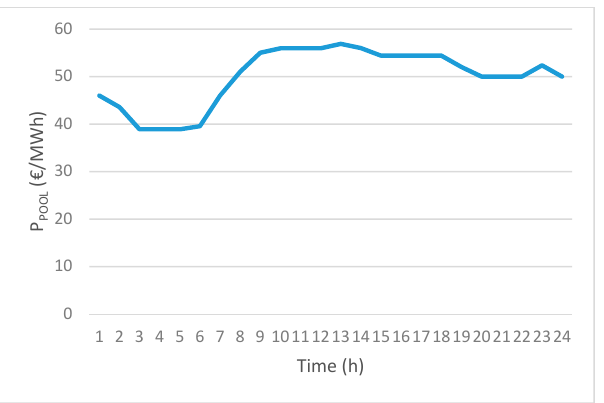
Figure 6. Electricity market price.